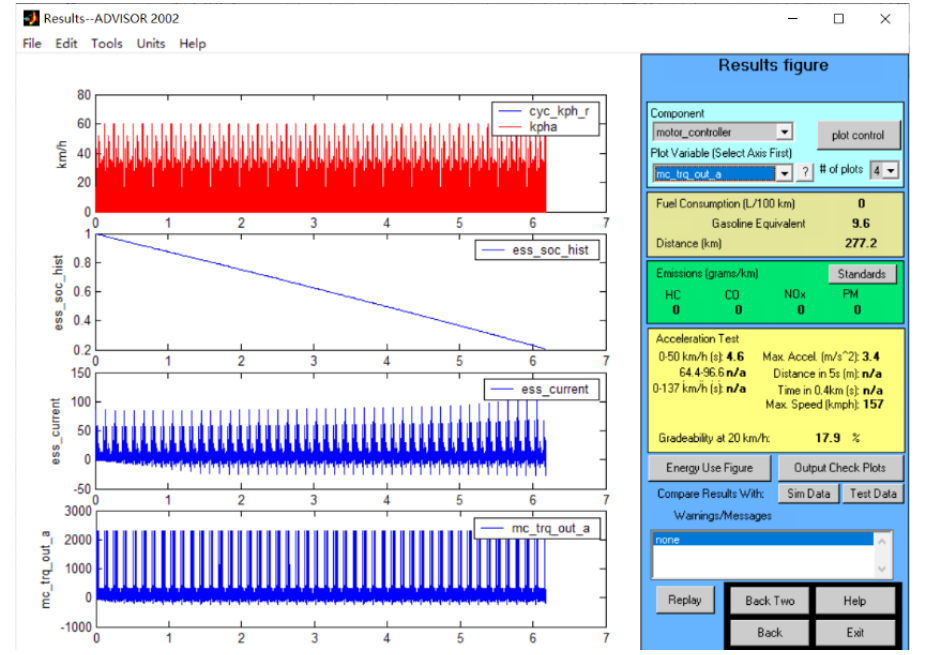
Figure 9. Simulation results of experiment 1.